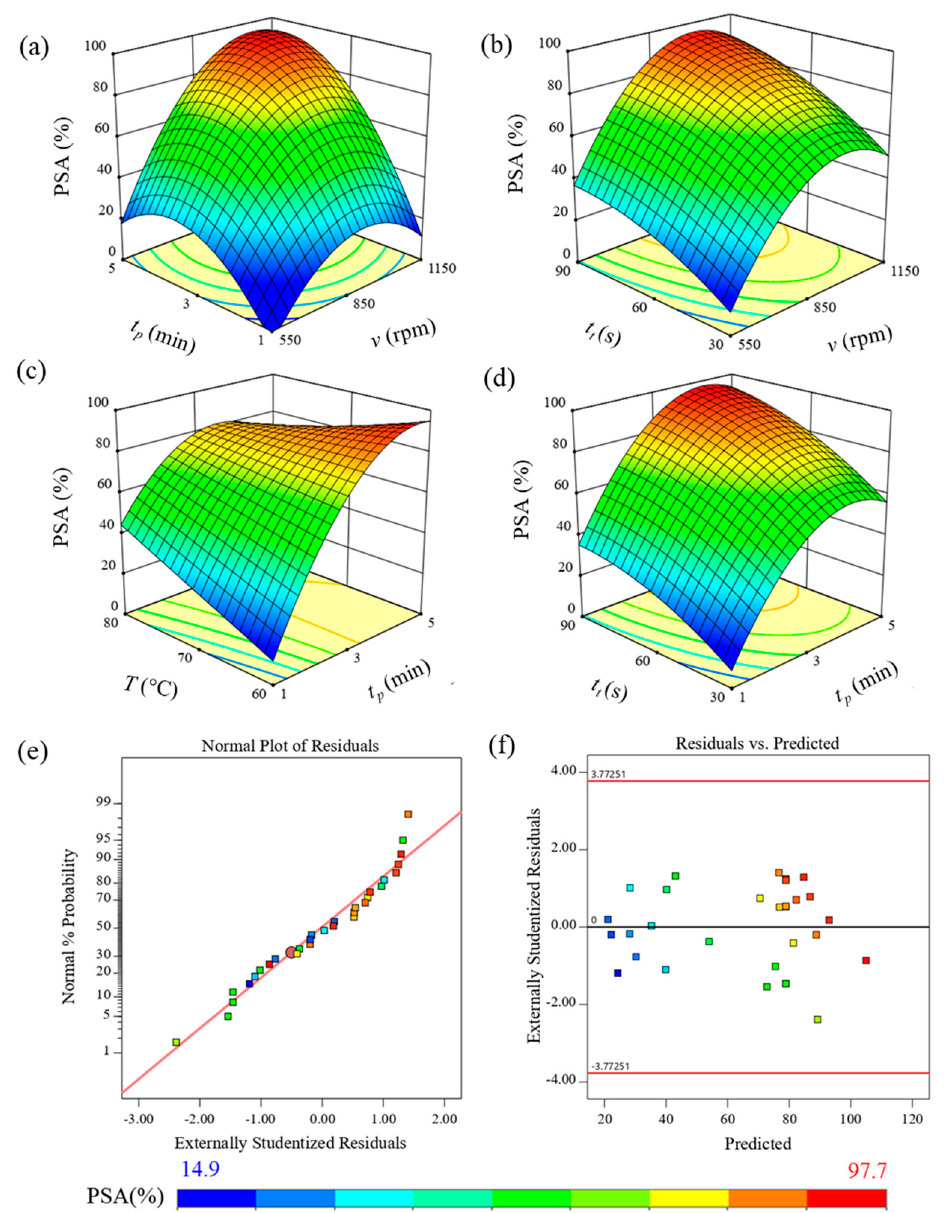
Figure 2. ( a – d ) Surface plots indicating the effect of the rotational speed of the brushes v (rpm), peeling time t p (min), thawing temperature T (°C), and incubation time t t (s) on the peeled surface area PSA (%) of cassava tubers while keeping the other variables constant. ( e ) Normal probability plot of the residuals of PSA. ( f ) Plot of residuals versus predicted values of PSA.